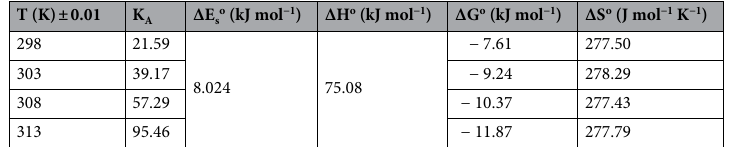
Table 5. Calculations of the radii of the ions for Sodium N , N -Dimethyl dithiocarbamate in Dimethylformamide at 25, 30, 35 and 40 °C and 1 atm (note: (1) ohm −1 equiv −1 cm 2 (2) ohm −1 equiv −1 cm 2 p).